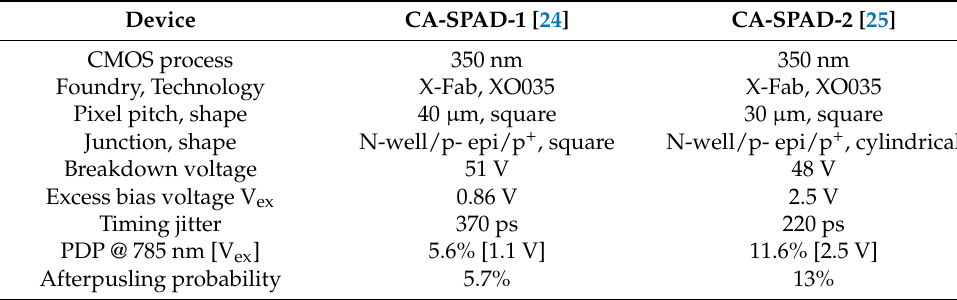
Table 4. Performance parameters of CA-SPADs.